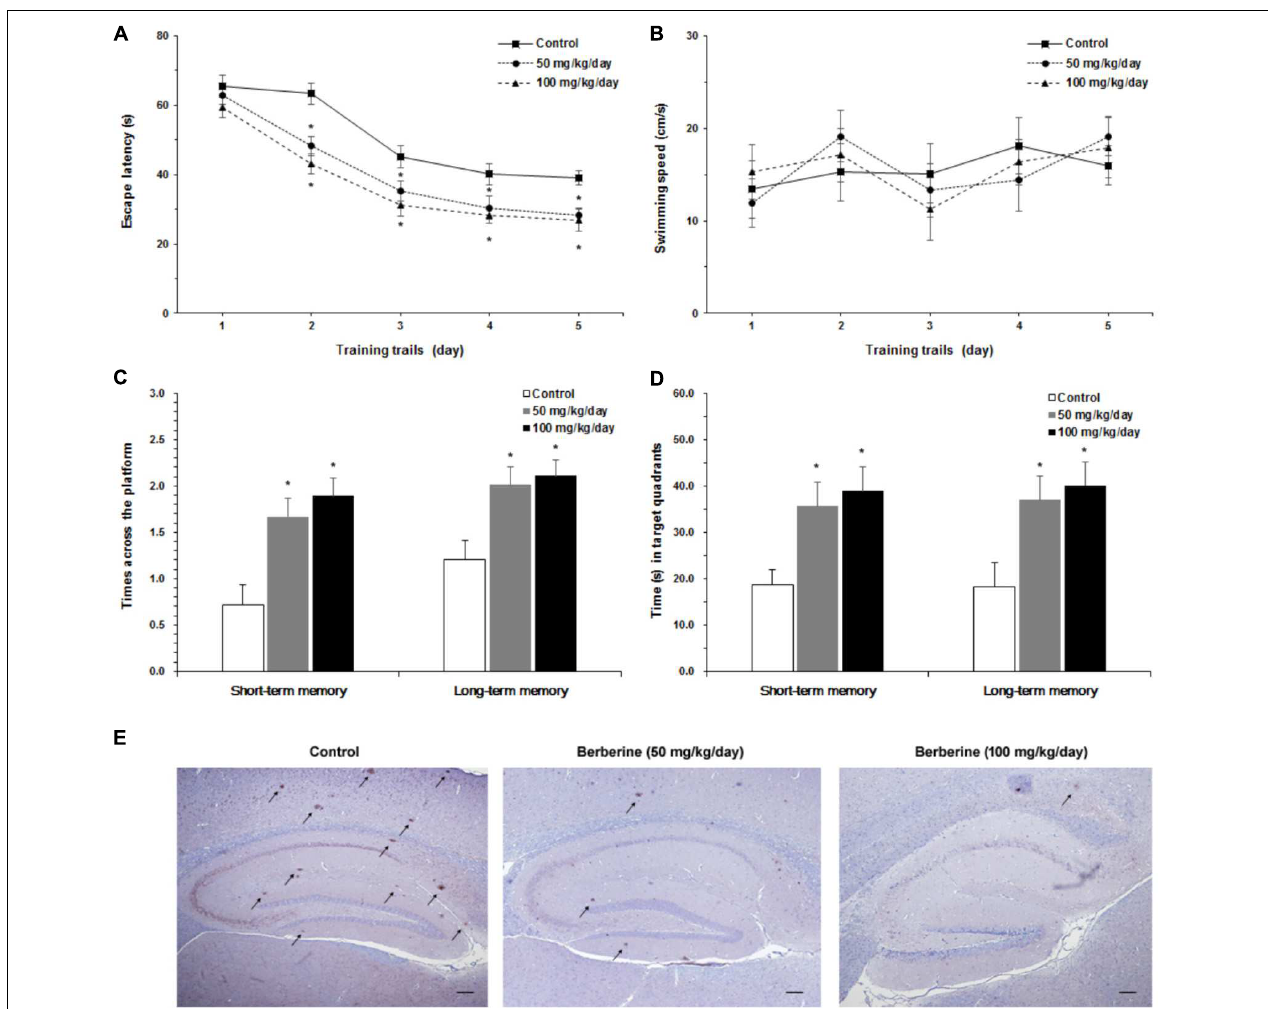
FIGURE 5 | The neuroprotective properties of berberine in AD. Effect of berberine on spatial learning and memory of APP/PS1 mice were assessed by Morris water maze task. (A) The escape latency of mice were measured in 5-day training trials. Significant improvement in escape latency were observed in the berberine-treated mice ( p < 0.05). (B) The swimming speed of mice during training trails. (C) The number of times crossing the target quadrant in both short-term memory and long-term memory. (D) The time of mice searching for the pre-placed platform in the target quadrant, in both short-term memory and long-term memory. Data shown are means ± SEM ( n = 10). Significance was calculated by Student’s t -test. ∗ p < 0.05. (E) Immunohistochemistry staining of the mice brain tissues with anti-A β 1 - 42 antibody (4G8). Scale bar is 200 µ